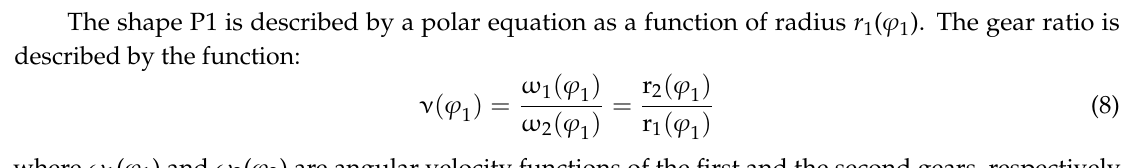
Figure 11. Roll lines representing a non-circular gear; P1, P2—roll lines, O1, O2—rotation centers.